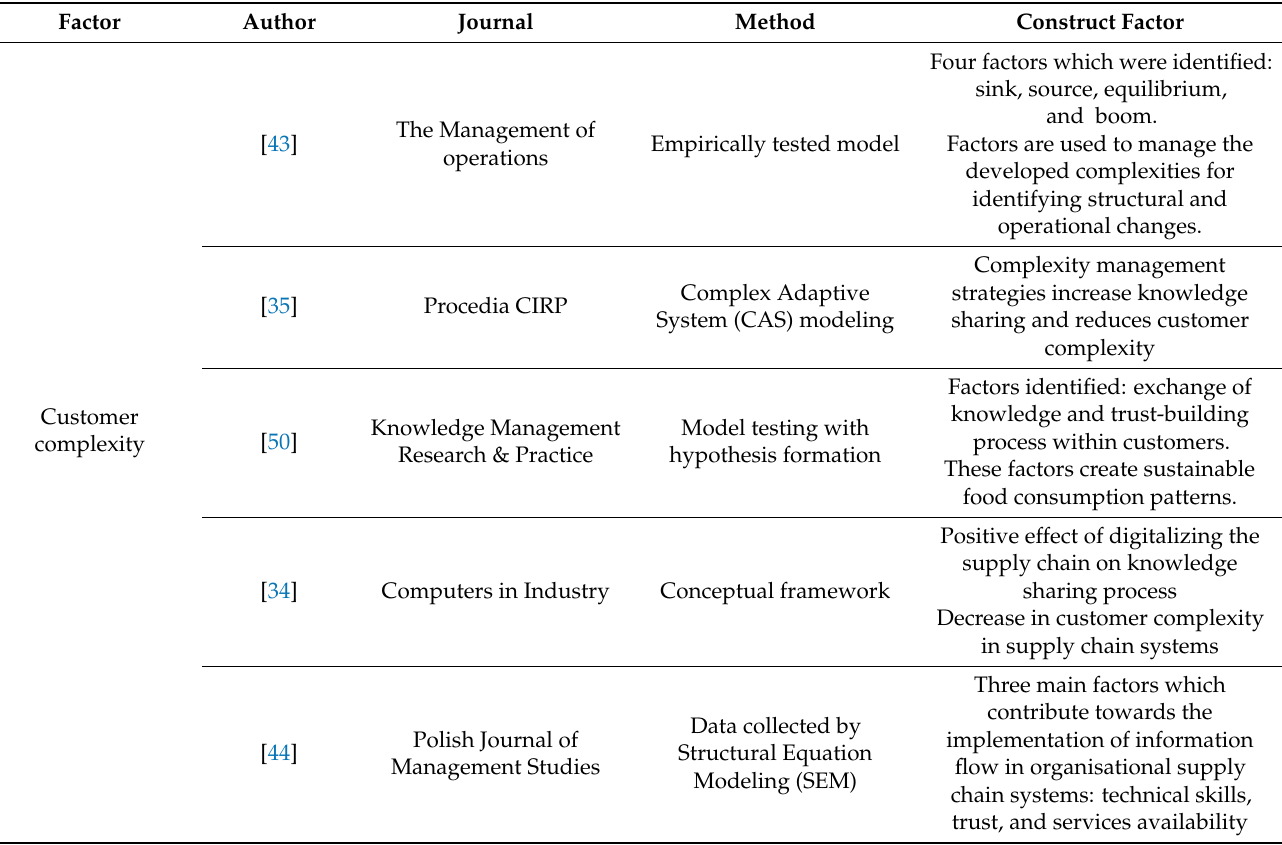
Table 5. Construct factors gathered for customer complexity (author’s